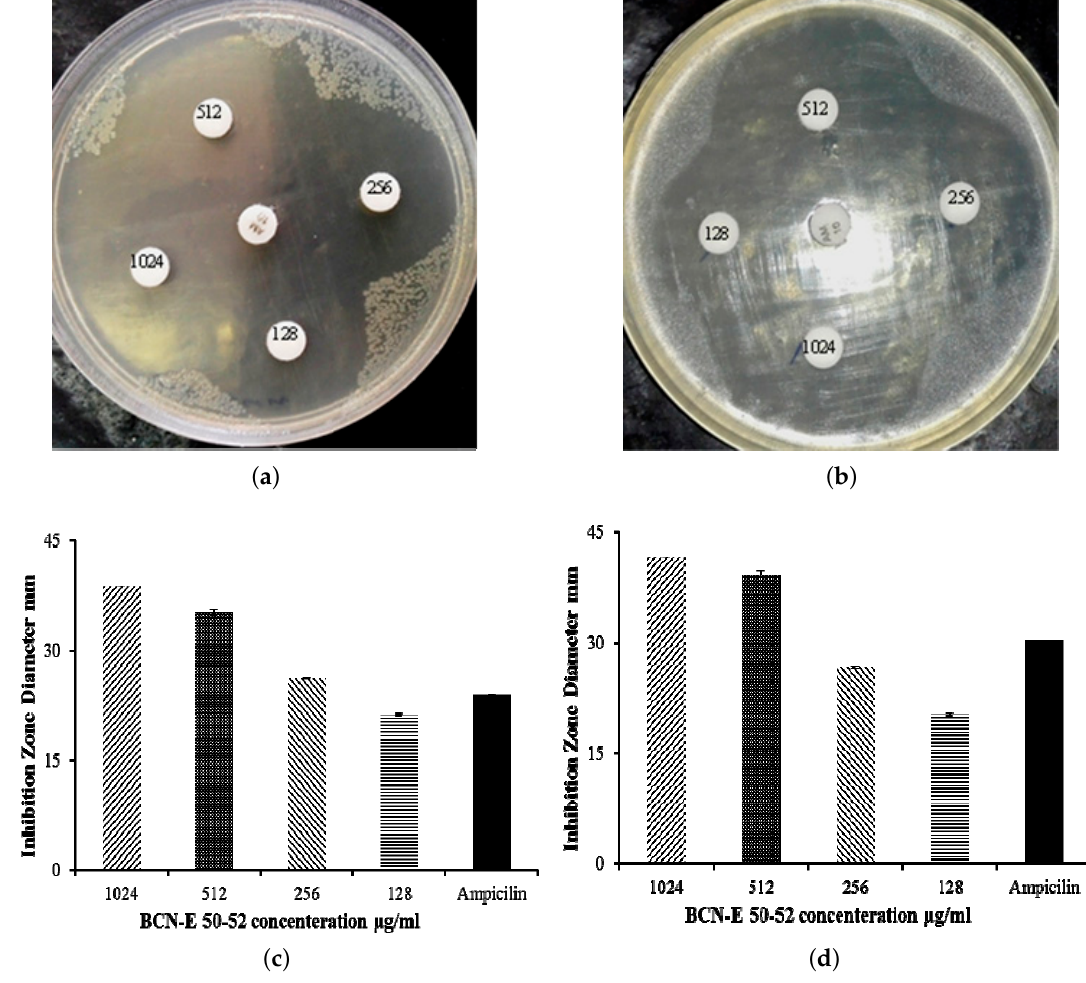
Figure 2. Agar disk diffusion of BCN E 50-52 against ( a ) E. coli and ( b ) S. aureus. BCN E 50-52 concentrations are written on disks in µg/mL. Inhibition zone diameters of BCN E 50-52 against ( c ) E. coli and ( d ) S. aureus.